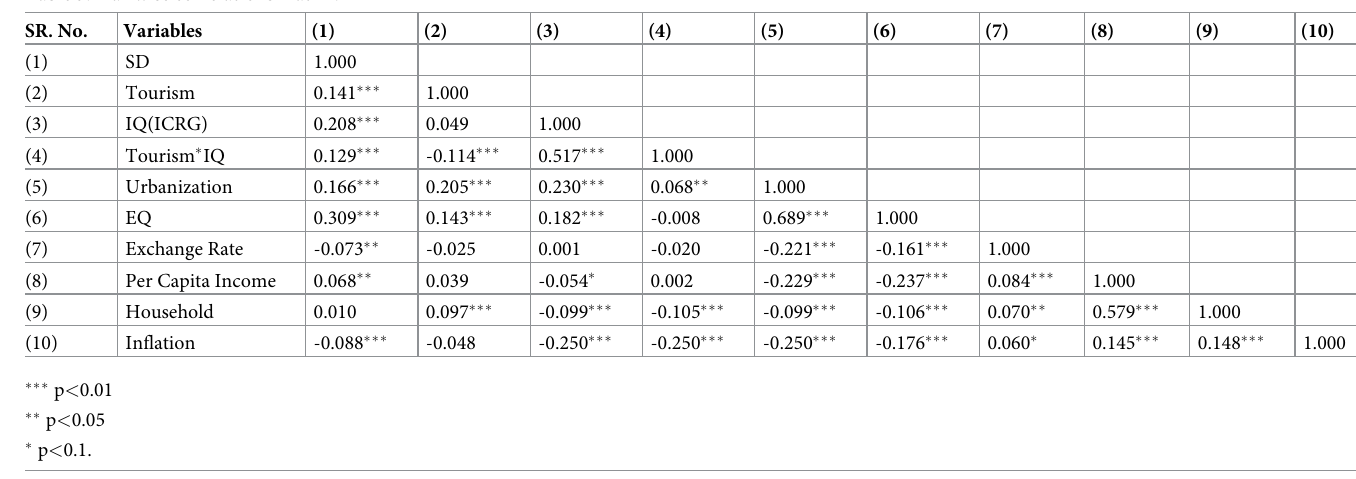
Table 3. Pairwise correlations